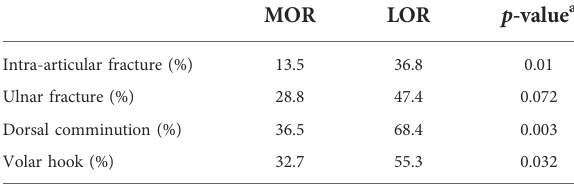
TABLE 3 Comparison of the presence of radiologic risk factors between the two groups.